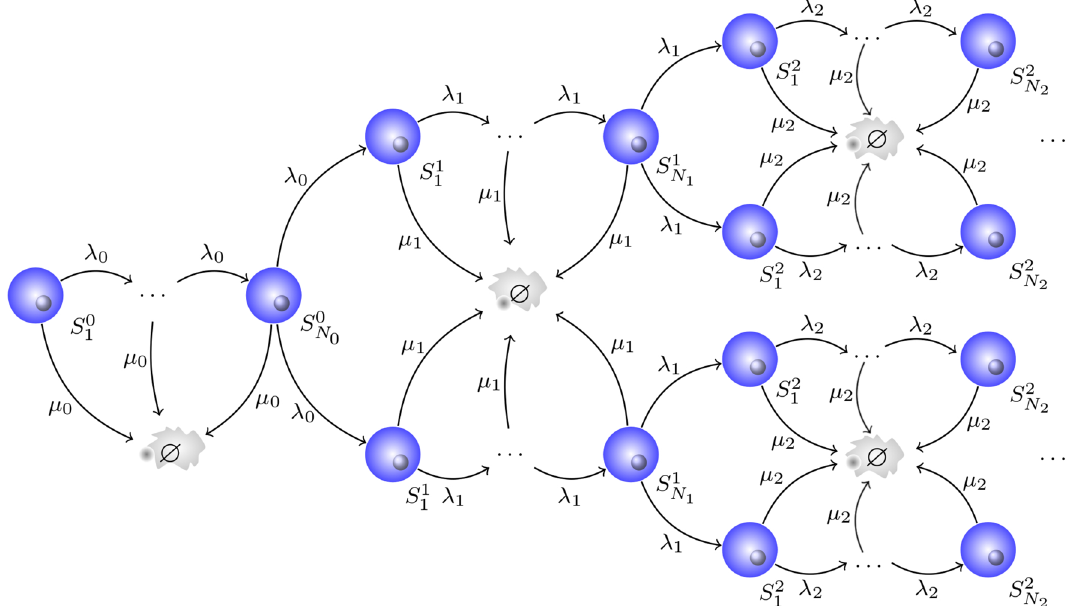
Figure 2. Multi-stage model with cell generations (MS-G model). Each cell in the first stage of generation 0 has to visit all the N 0 compartments (or stages) in order to divide. When cells arrive at the last stage of generation 0, N 0 , they may divide with birth rate (cid:31) 0 , or die with death rate µ 0 . If a cell divides, its daughter cells join the first compartment of the next generation, and the process